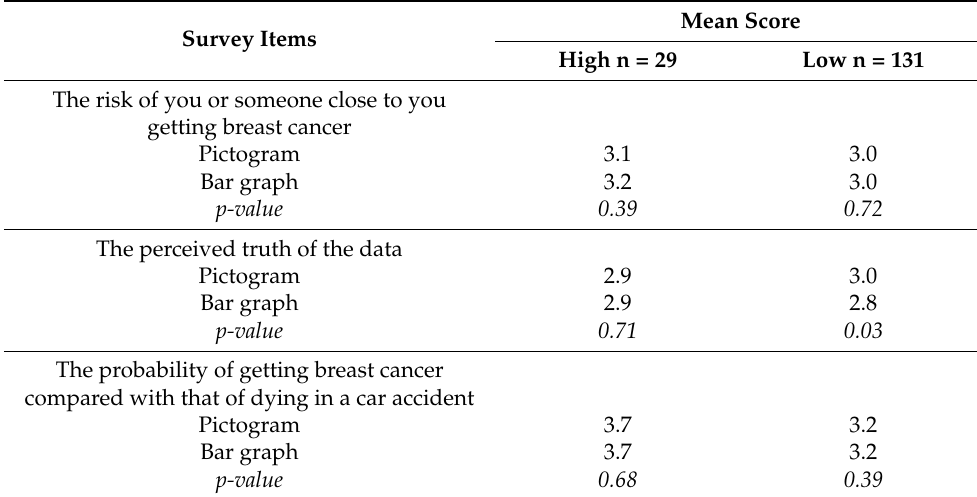
Table 4. Differences in risk perception and data reliability depending on data presentation style: stratified by health literacy level.